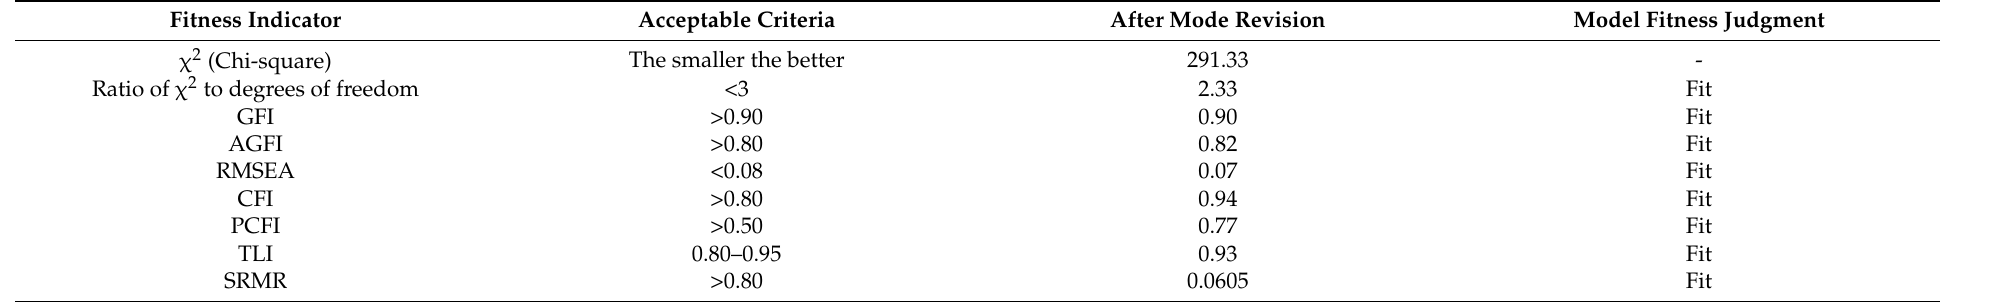
Table 5. Overall fitness analysis of the study model.